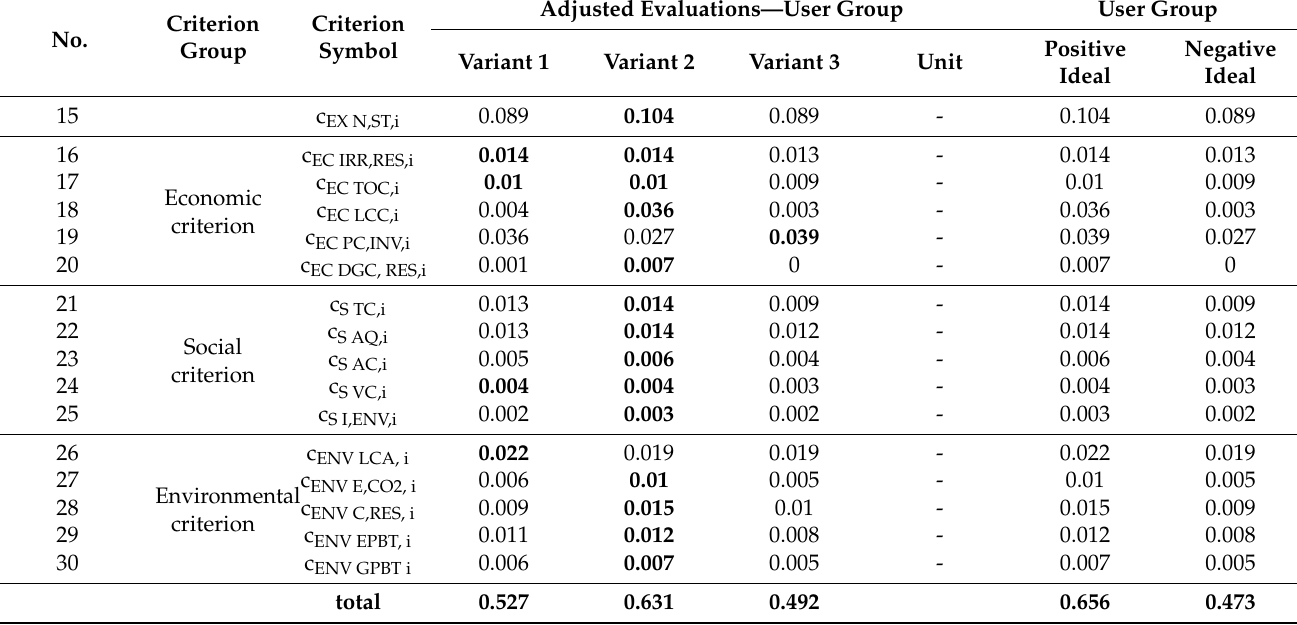
Table 12. Adjusted evaluations of the sub-criteria of evaluation for individual variants—the “Designer/Architect” group.